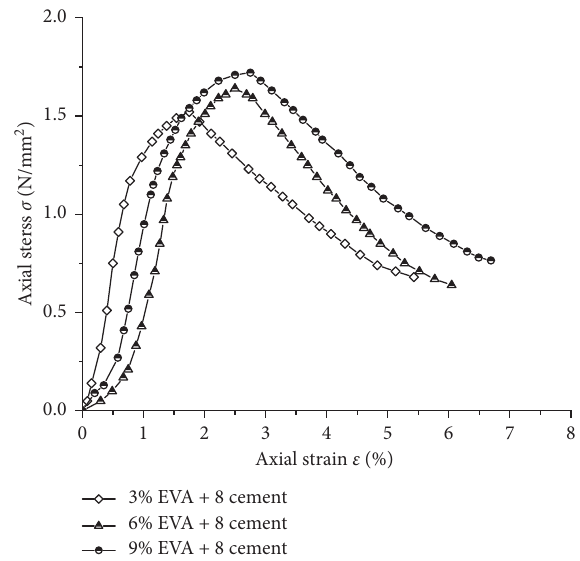
Figure 6: Correlation of stress and strain: soil treated with various fractions of EVA and 8%